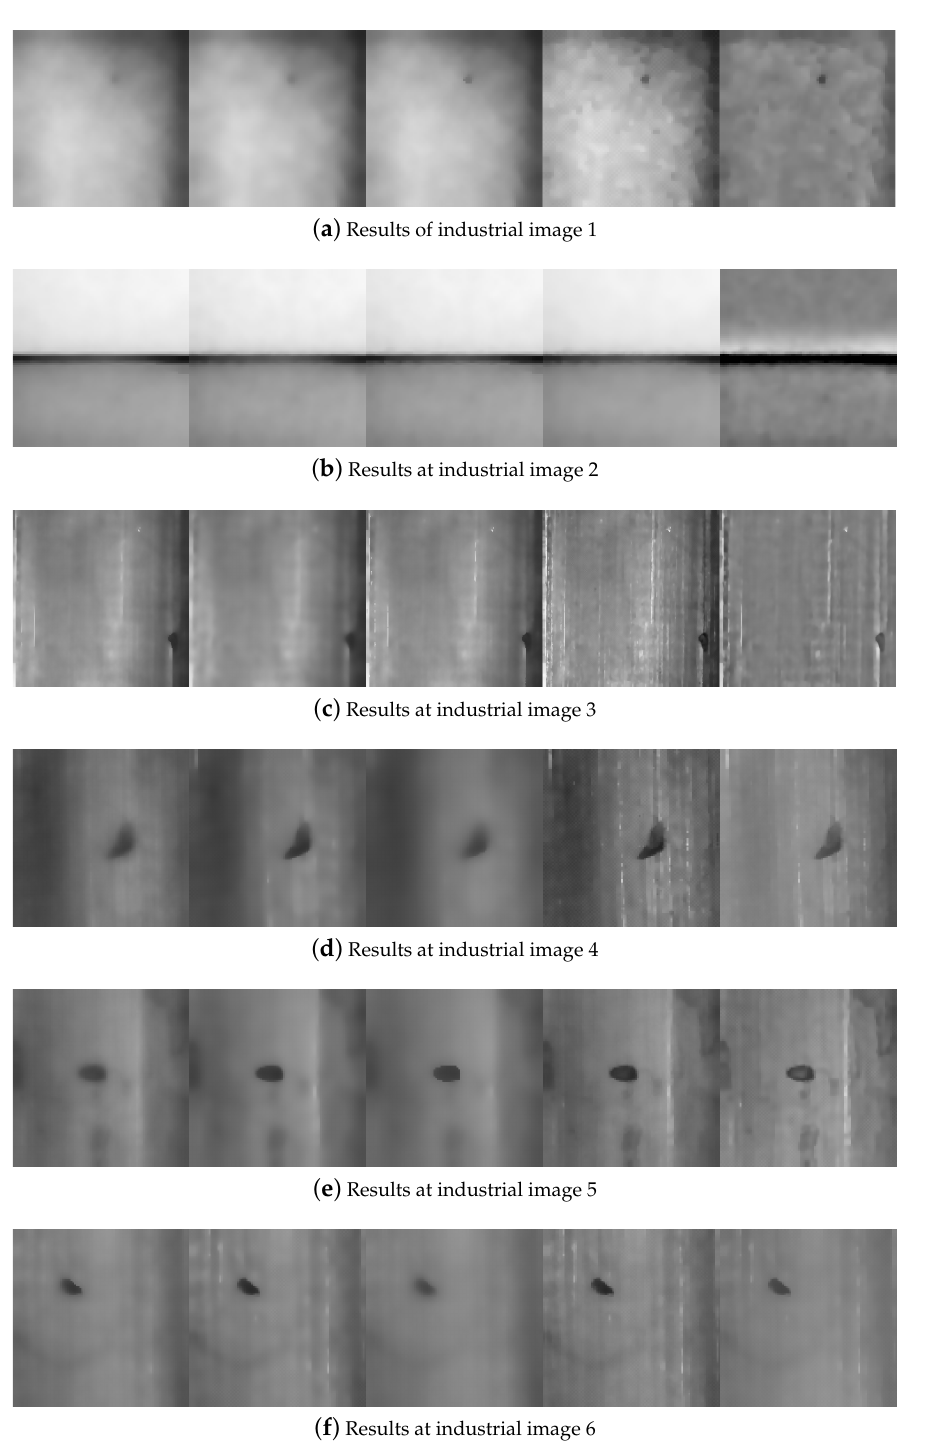
Figure 11. Results of Industrial images in Experiment